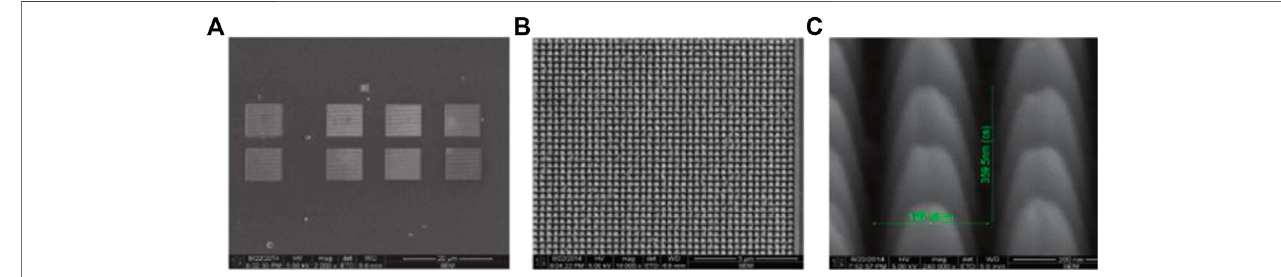
FIGURE 9 | (A) Schematic diagramofminimum repeat unitinregular nanowire array, (B) Opticalabsorption performance ofnanowire arrays withdifferent heights, (C) Optical absorptivity performance at different D/P ratios, (D) Optical absorptivity performance of nanowires with different diameters. Source : Reproduced from Ref. 31.